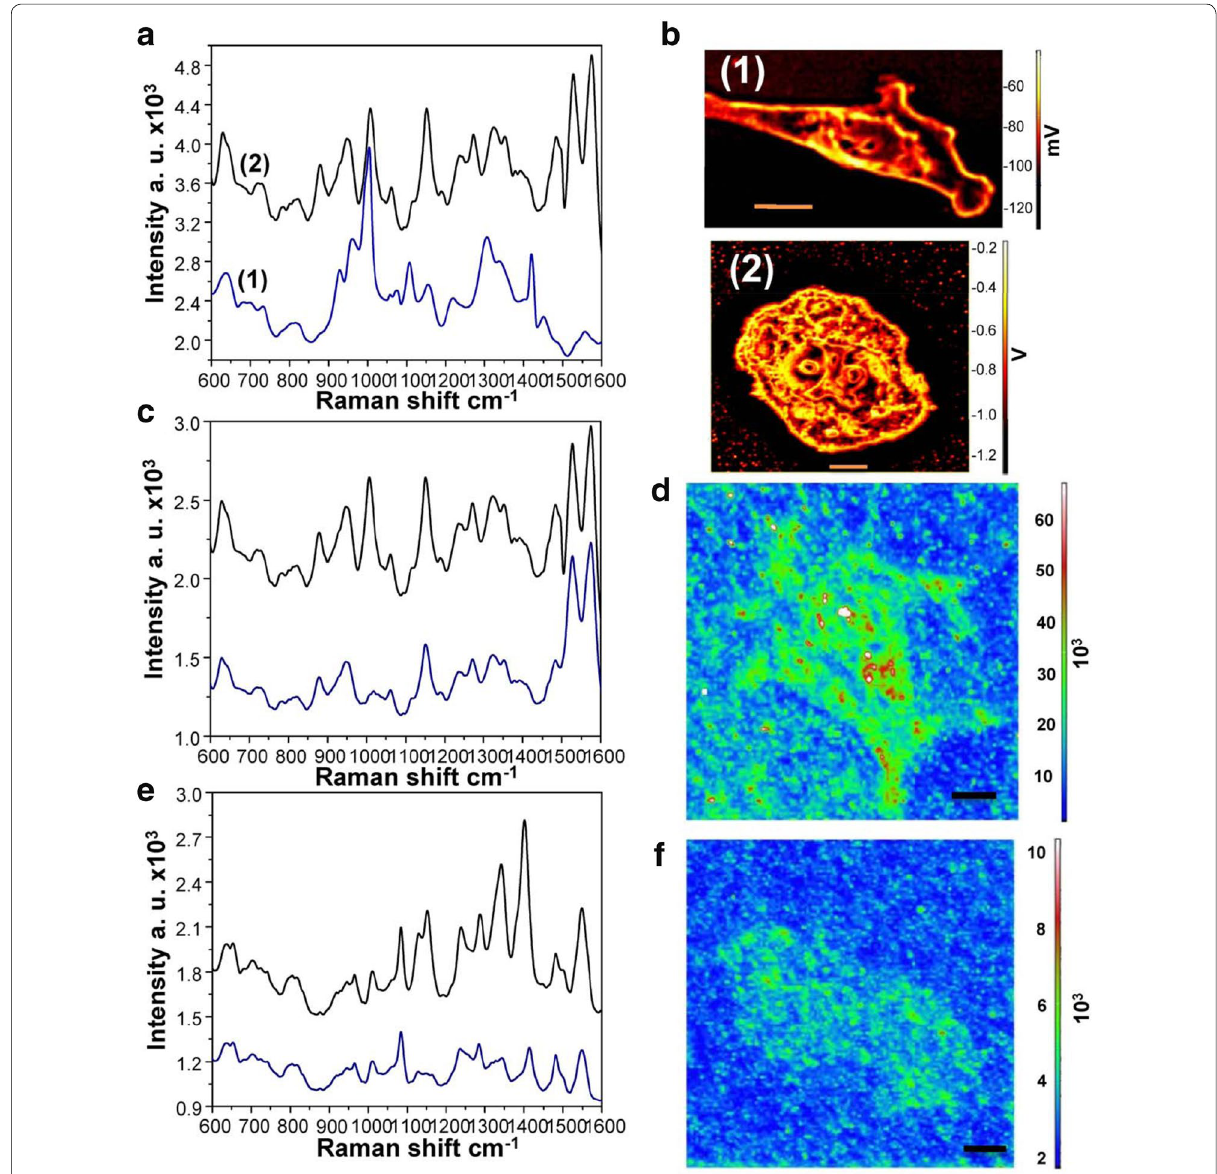
Fig. 9 SERS monitoring at different cell cycle stages. a SERS spectra of (black) resting HMEC cells (G0/G1) and (blue) mitotic HMEC cells (S/G2). b Confocal images of HMEC cells in the (1) resting state (G0/G1) and (2) mitotic state (S/G2), c SERS spectra of HMEC cells from cytoplasm (blue curve) and the nucleus (black curve), and d SERS map image of HMEC cells. e SERS spectra of HepG2 cells from cytoplasm (blue curve) and the nucleus (black curve), and f SERS map image of HepG2 cells. Scale bar: 10 mm (Reprinted from [96]. Copyright @ 2011 PloS